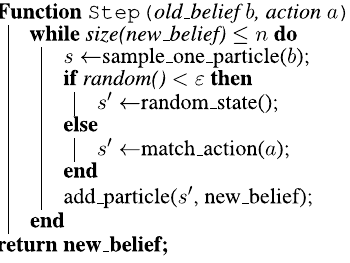
FIGURE 3 | The experimental setup, in which a human participant engages in a joint construction task with the Baxter Robot. In the picture, the robot is supporting its human partner by holding a leg of the table while the human is screwing. See Section 4.2 for information about the task.